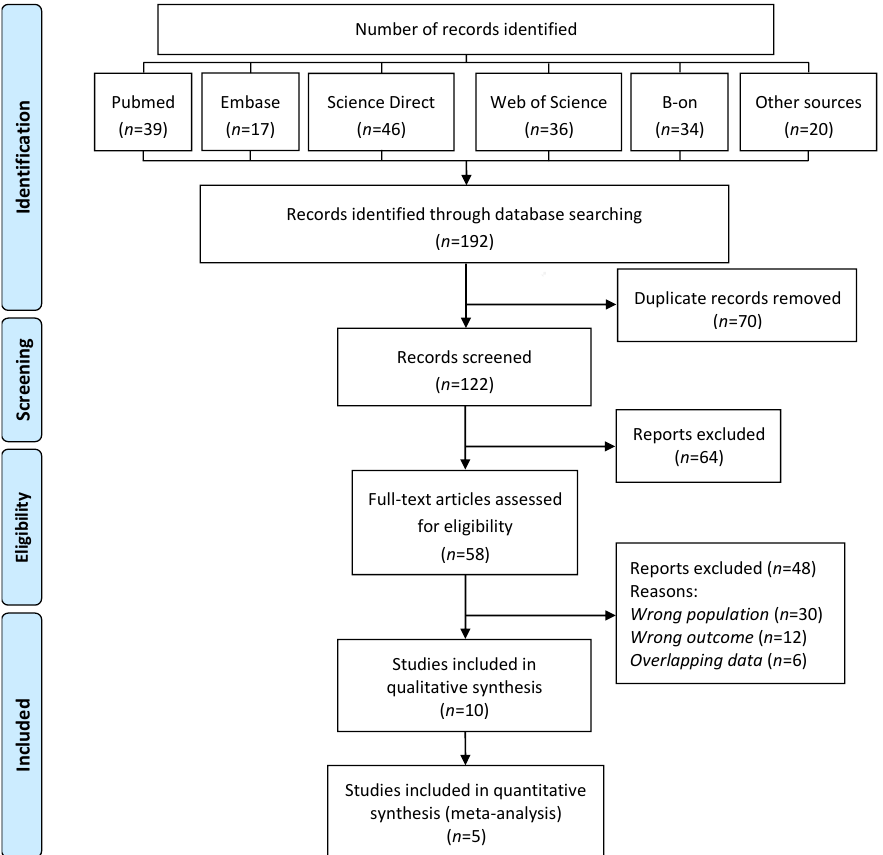
Figure 1. PRISMA flow diagram for the systematic review on the association between environmental exposure to cadmium and risk of osteoporosis in postmenopausal women.